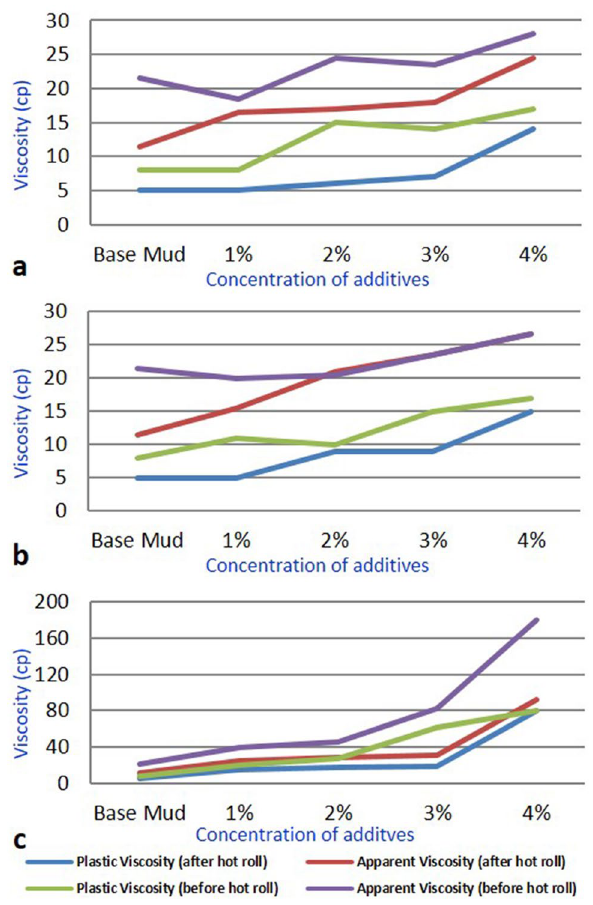
Fig. 7 PV, AV comparison of developed drilling fluid formulations with base mud before and after hot roll a 250–297 µm, b 63–74 µm,